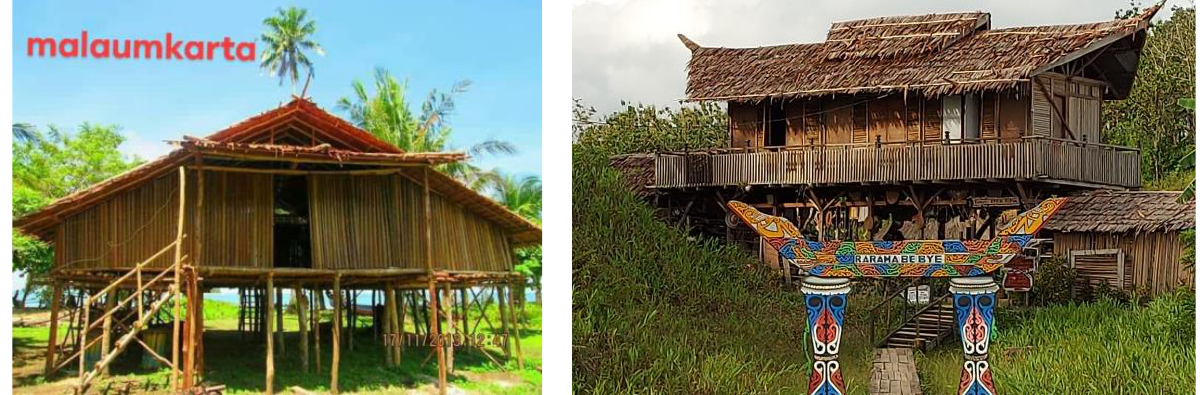
Figure 1. Traditional building design using sago midrib for the house’ s roof.